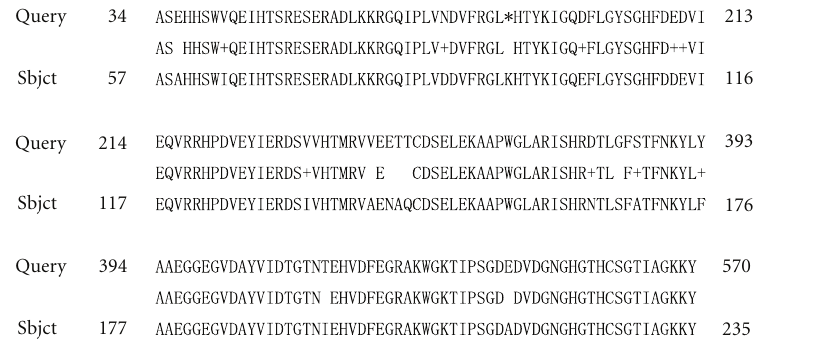
Figure 1: DV546294 shared 90% identity with serine proteases of Acremonium sp.